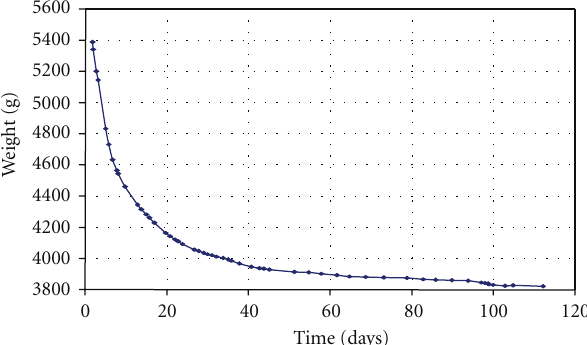
Figure 12: Weight lost of the lime-hemp test piece with time.